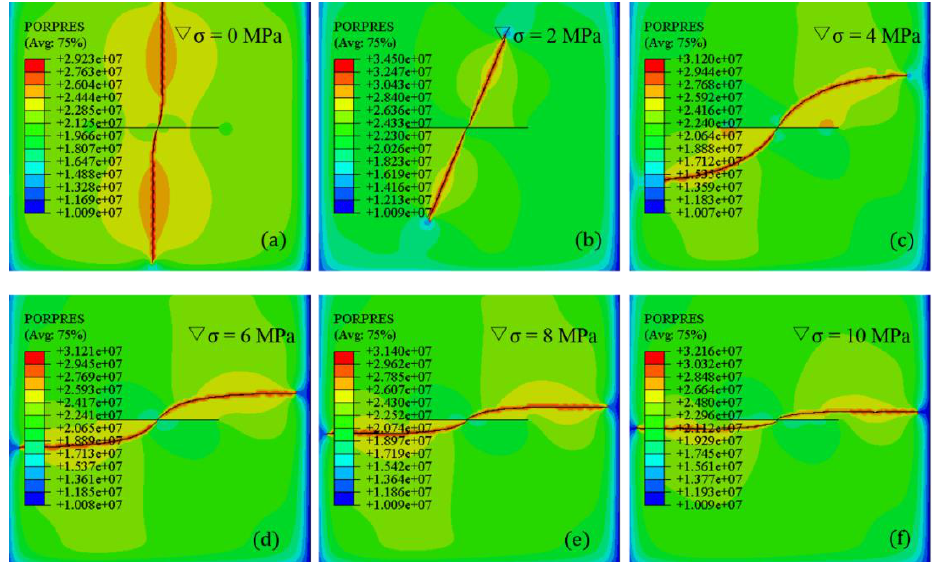
Figure 9. Reorientation behavior of refracturing fractures with different horizontal stress difference (PORPRES present the pore-pressure with enrichments: unit is Pa).